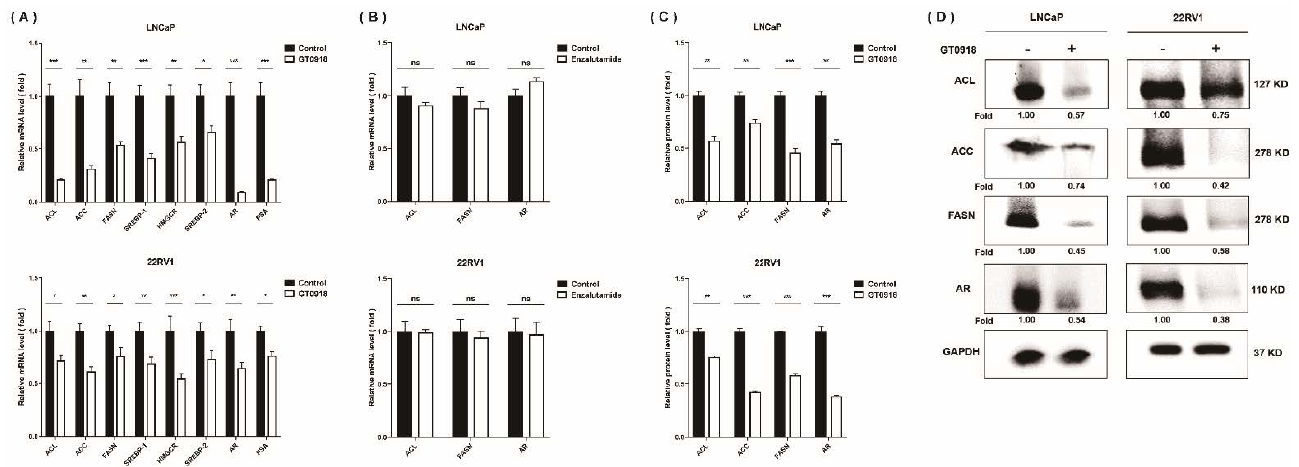
Figure 5. The effects of proxalutamide (GT0918) on AR expression and lipid de novo synthesis in PCa cells. ( A ) Proxalutamide significantly inhibited the mRNA expression of ATP citrate lyase ( ACL ), acetyl CoA carboxylase ( ACC ), fatty acid synthase ( FASN ), sterol regulatory element-binding protein-1/2 ( SREBP -1/2), 3-hydroxy-3-methylglutaryl-coenzyme A reductase ( HMGCR ), prostate-specific antigen ( PSA ) and AR in LNCaP and 22RV1 cells. ( B ) Enzalutamide did not significantly affect the mRNA expression of ACL , FASN and AR in LNCaP and 22RV1 cells. The relative mRNA level was defined as 1.0 (fold) in the vehicle-treated (control) cells. Data were normalized by β -actin mRNA expression and shown as the mean ± SD ( n = 5). ‘ns’ p > 0.05, * p < 0.05, ** p < 0.01, *** p < 0.001. ( C , D ) Proxalutamide significantly reduced the protein amounts of ACL, ACC, FASN and AR in LNCaP and 22RV1 cells. GAPDH was used as a loading control in Western blotting assay. The relative fold was defined as 1.00 in the vehicle-treated LNCaP or 22RV1 cells, respectively. Data were normalized by GAPDH protein expression and are shown as the mean ± SD ( n = 3). ** p < 0.01, *** p < 0.001.